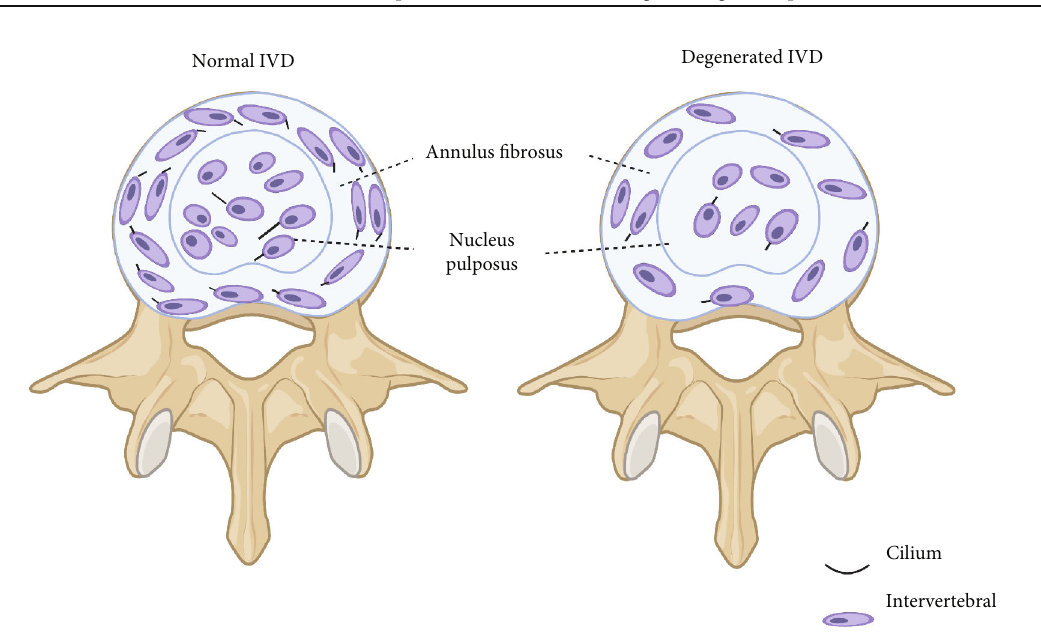
Figure 3: Cilium orientation of the normal and degenerated intervertebral disc (IVD). The IVD consisted of nucleus pulposus (NP), annulus fi brosus (AF), and endplate cartilage (EP). The primary cilia in AF are well organized and orientated: primary cilia were always projected from the inner sides of AF cells (near the NP), and they are oriented parallel to the long axis of the cells. The cilia in NP were disorganized and with varied cilium length. However, in the degenerated IVD, the cilia are disorganized in AF and cilium length and cilium incidence are reduced in both NP and